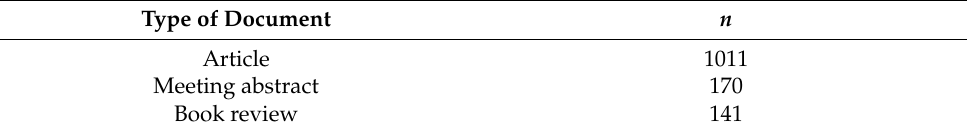
Table 4. Type of document.